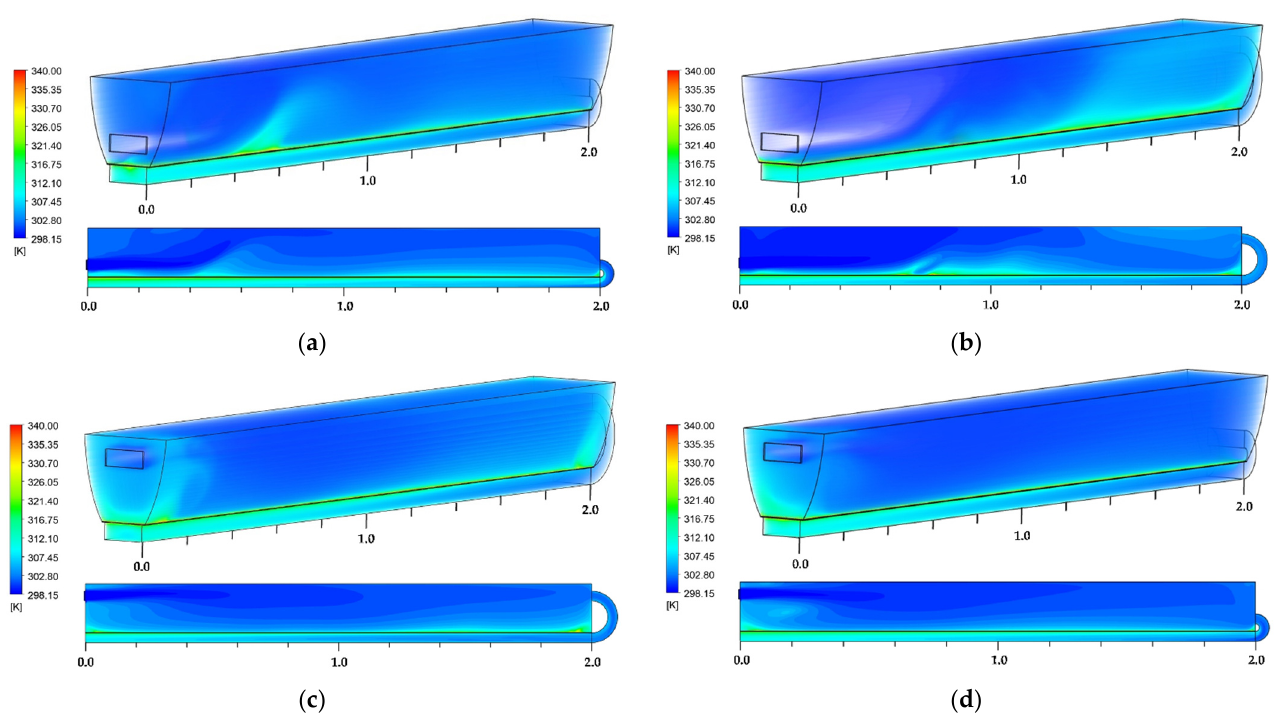
In Figure 7 (flow 2: 0.02 kg/s), the temperatures are lower than the ones observed in flow 1 (0.01 kg/s). In the four configurations, the temperature fields are highly dependent